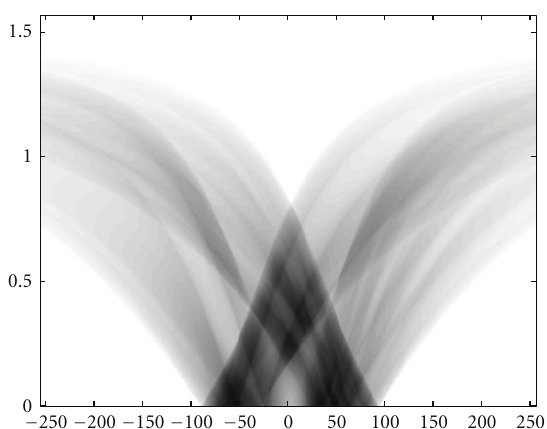
Figure 19: Original thyroid phantom.